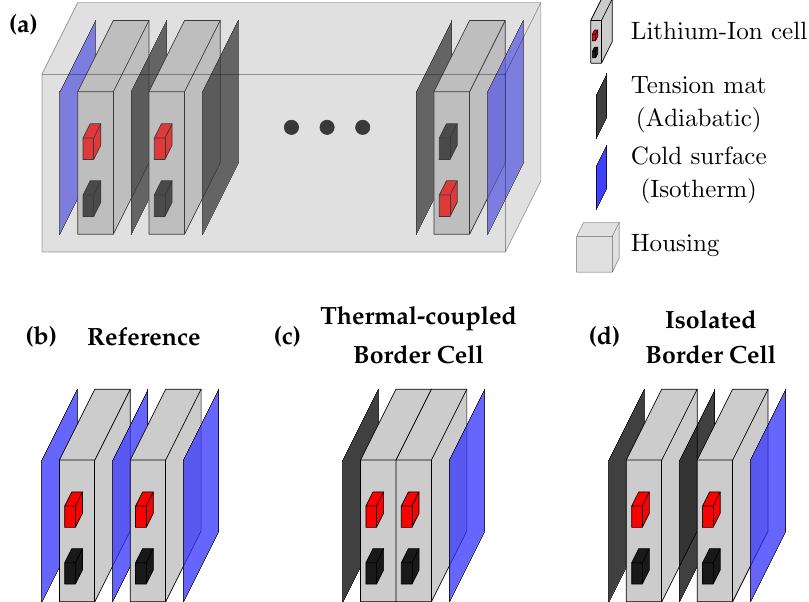
Figure 9. Impacts of the cell position and isolating tension mats on temperature gradients within a battery module ( a ). Considered scenarios: Reference ( b ), thermal-coupled border cell ( c ) and isolated border cell ( d ).